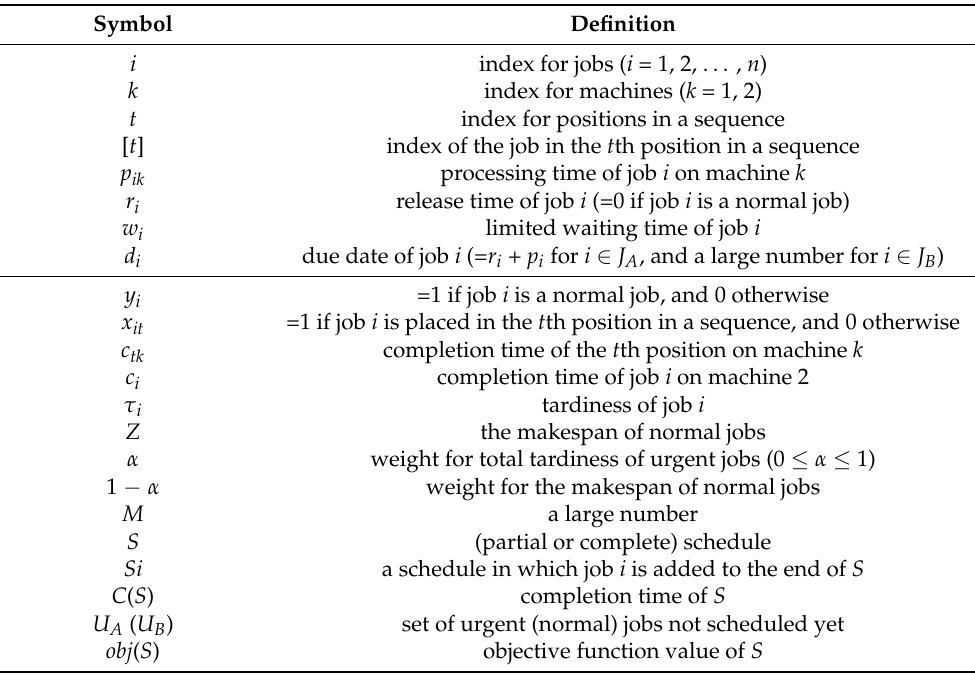
Table 1. Notation for parameters and decision